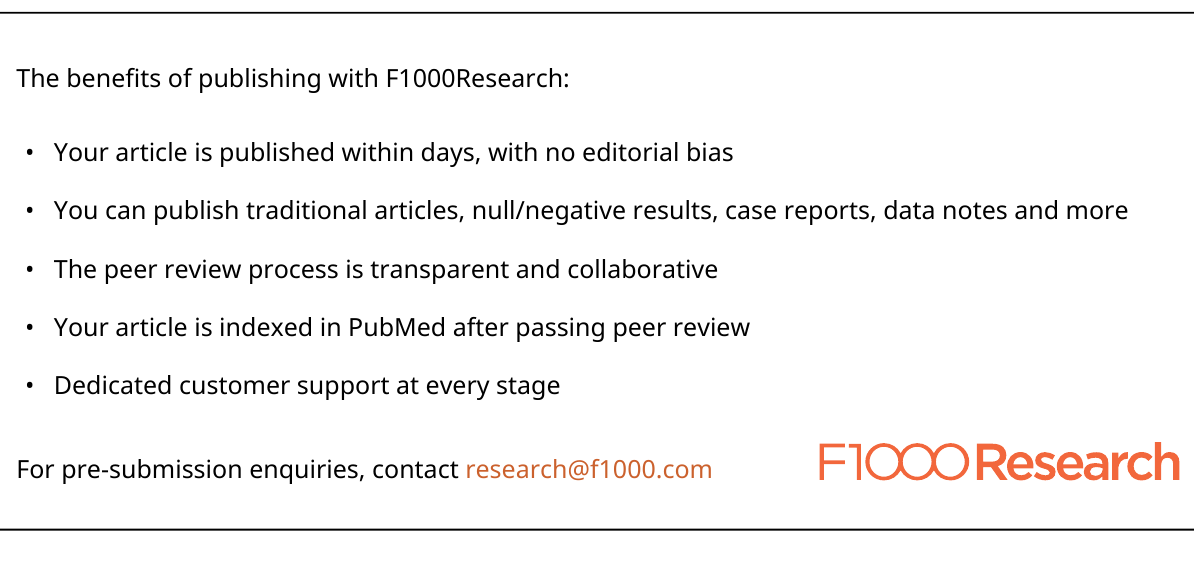
The terms created for the different phases of labor migration cycle make no sense. To the ○ best of my understanding, “pre-departure” means departure and “upon-arrival” means return. These terms are superfluous and are more jargon than they are informative.